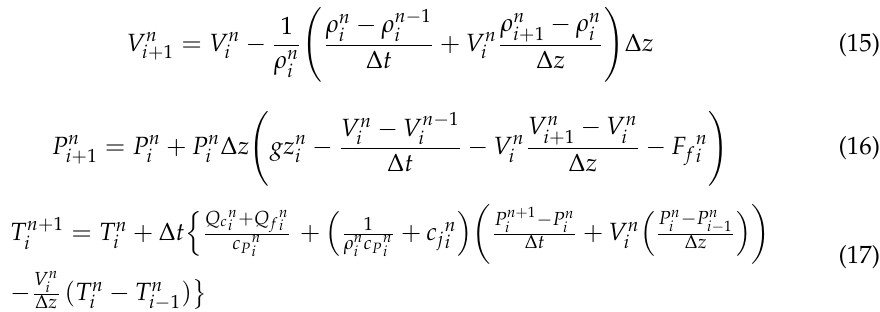
Table 1. The measured and simulated data of Cao-8 in the first